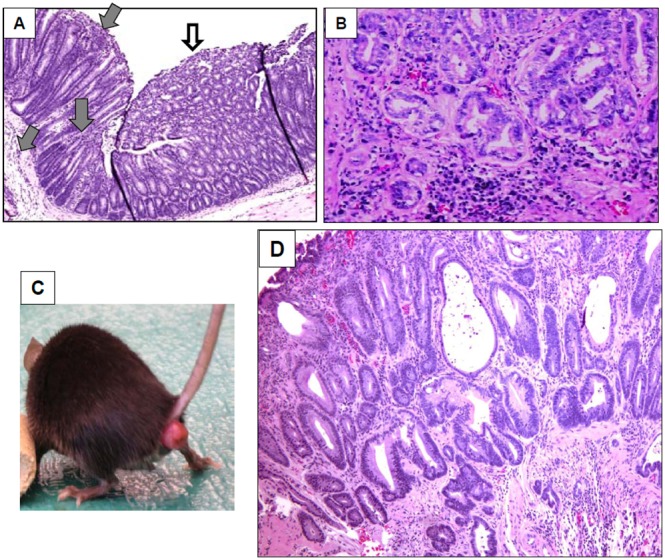

Muc2
−/− mice exhibited chronic inflammation and cancers in colon and rectum.A, Colitis and an adenoma in mouse colon at age of 3 months. Gray arrows pointed severe infiltration of inflammatory cells, white arrow pointed an adenoma. B, colonic adenocarcinoma with inflammatory cell infiltration at age of 6 months. C, Rectal prolapsed at 6 months. D, Histopathology of the rectal prolapse, showing cancer cell invasion and severe inflammation in the rectum (age of 6 months).